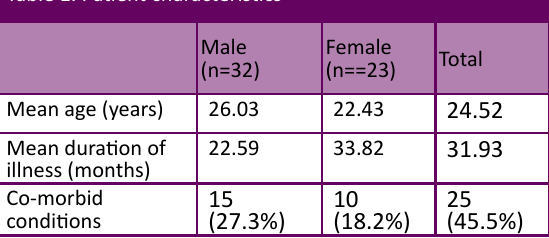
Table 1. Patient characteristics